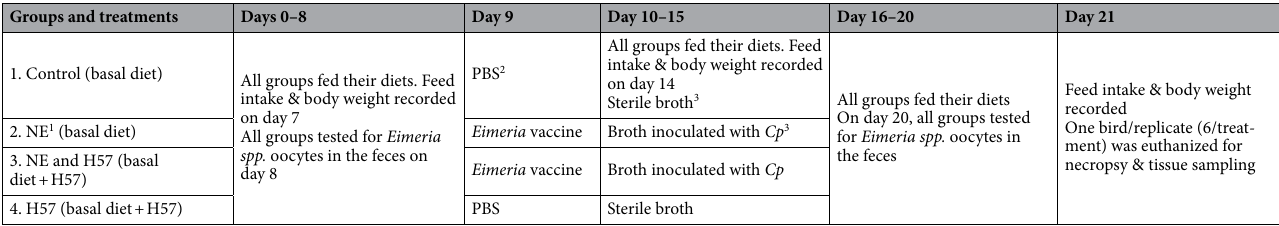
Table 2. Experimental groups and treatment details for chicks from day 0 to day 21. 1 NE-exposed chicks received a coinfection with Eimeria vaccine on day 9, and Clostridium perfringens ( Cp ) on days 14 and 15. 2 PBS and Eimeria vaccine was delivered in the drinking water (water was withheld for 3 hr prior treatments). 3 Sterile broth and broth inoculated with Cp was mixed with feed and given to birds; feed was withheld for 5 hr prior